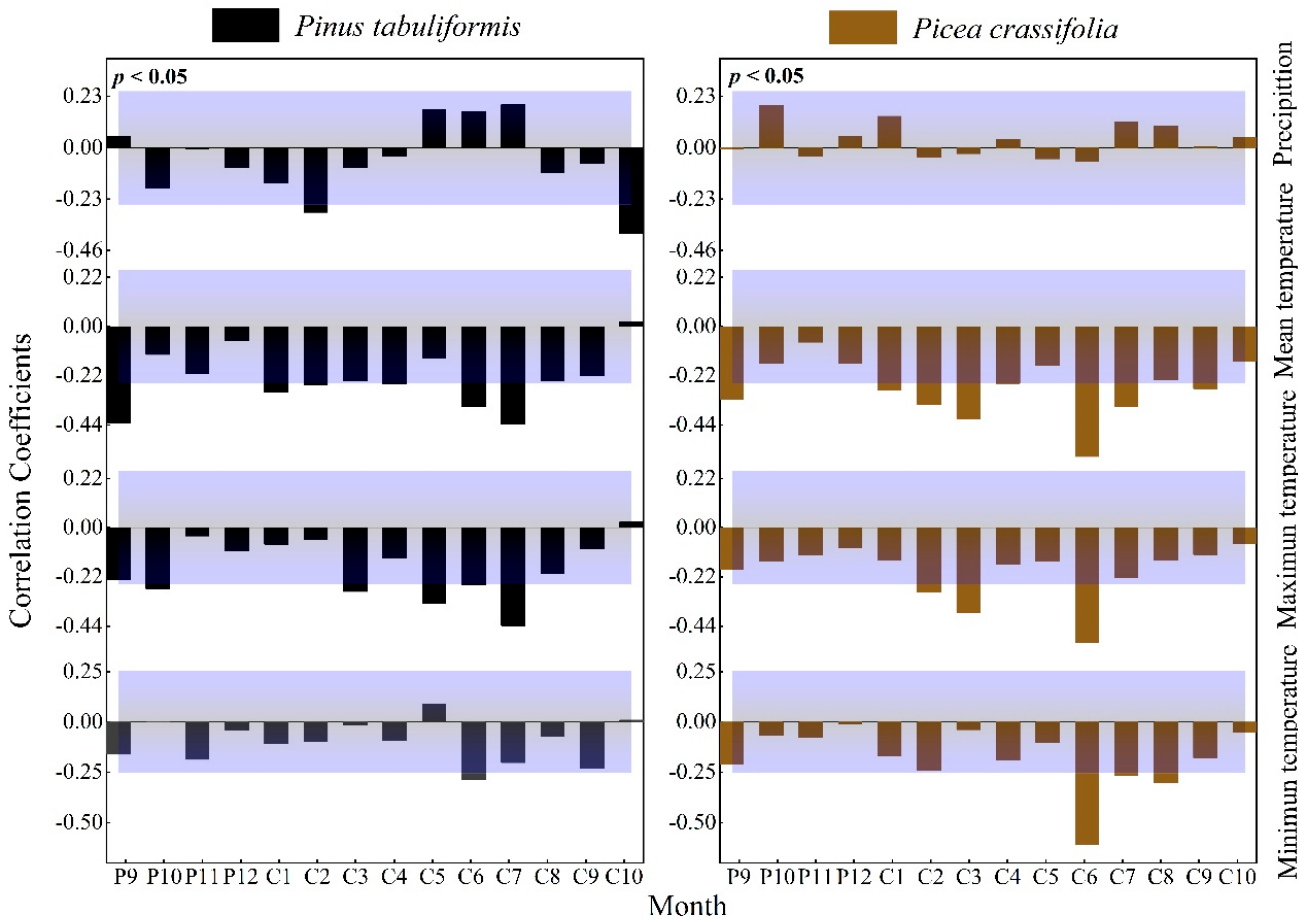
Figure 4. Response of the radial growth of trees to monthly values of climatic factors (Beyond the top of the purple shade, p values are positively correlated ( p < 0.05), lower than the part in purple shadow indicates that p values are negatively correlated ( p < 0.05).